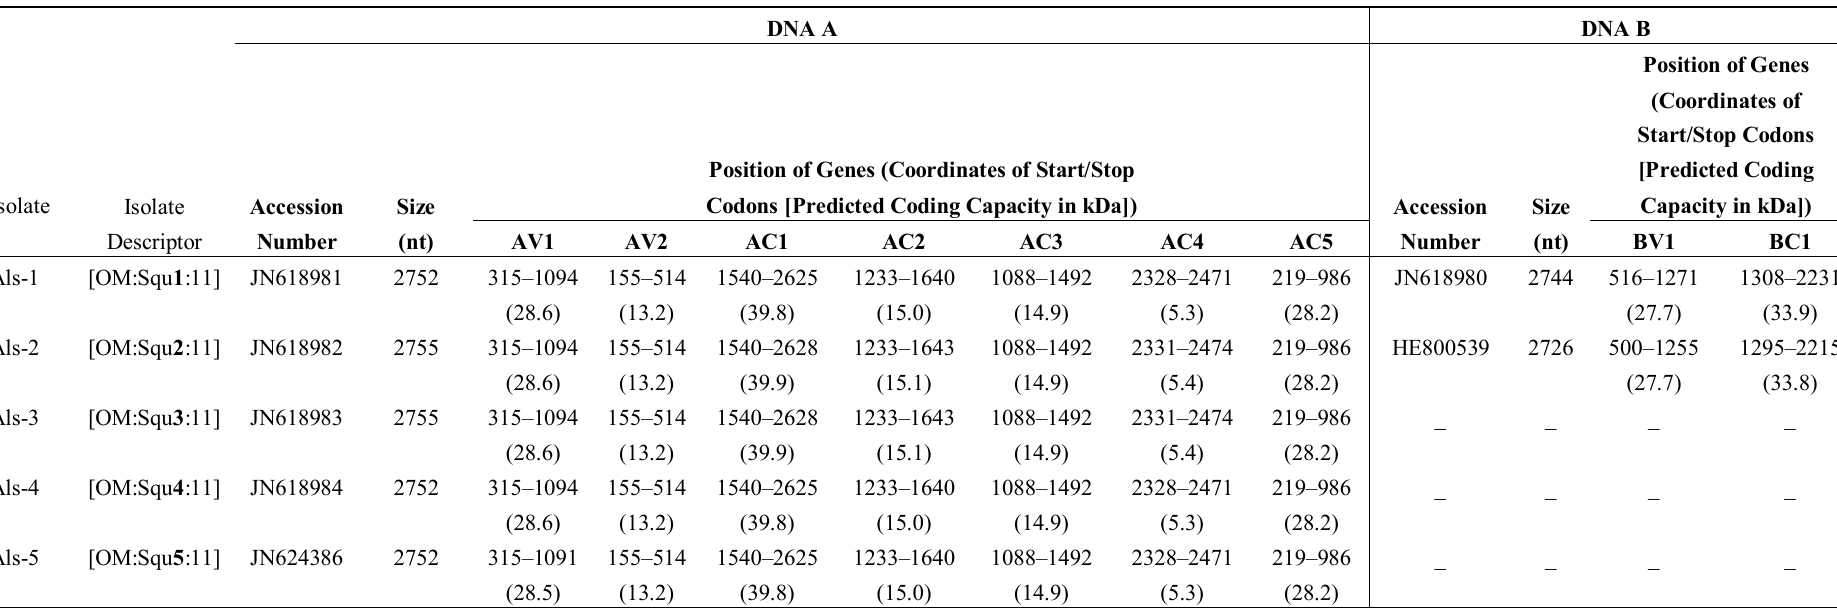
Table 1. Origins of virus isolates and features of the DNA A and DNA B components of Water melon chlorotic stunt virus from Oman. DNA A DNA B